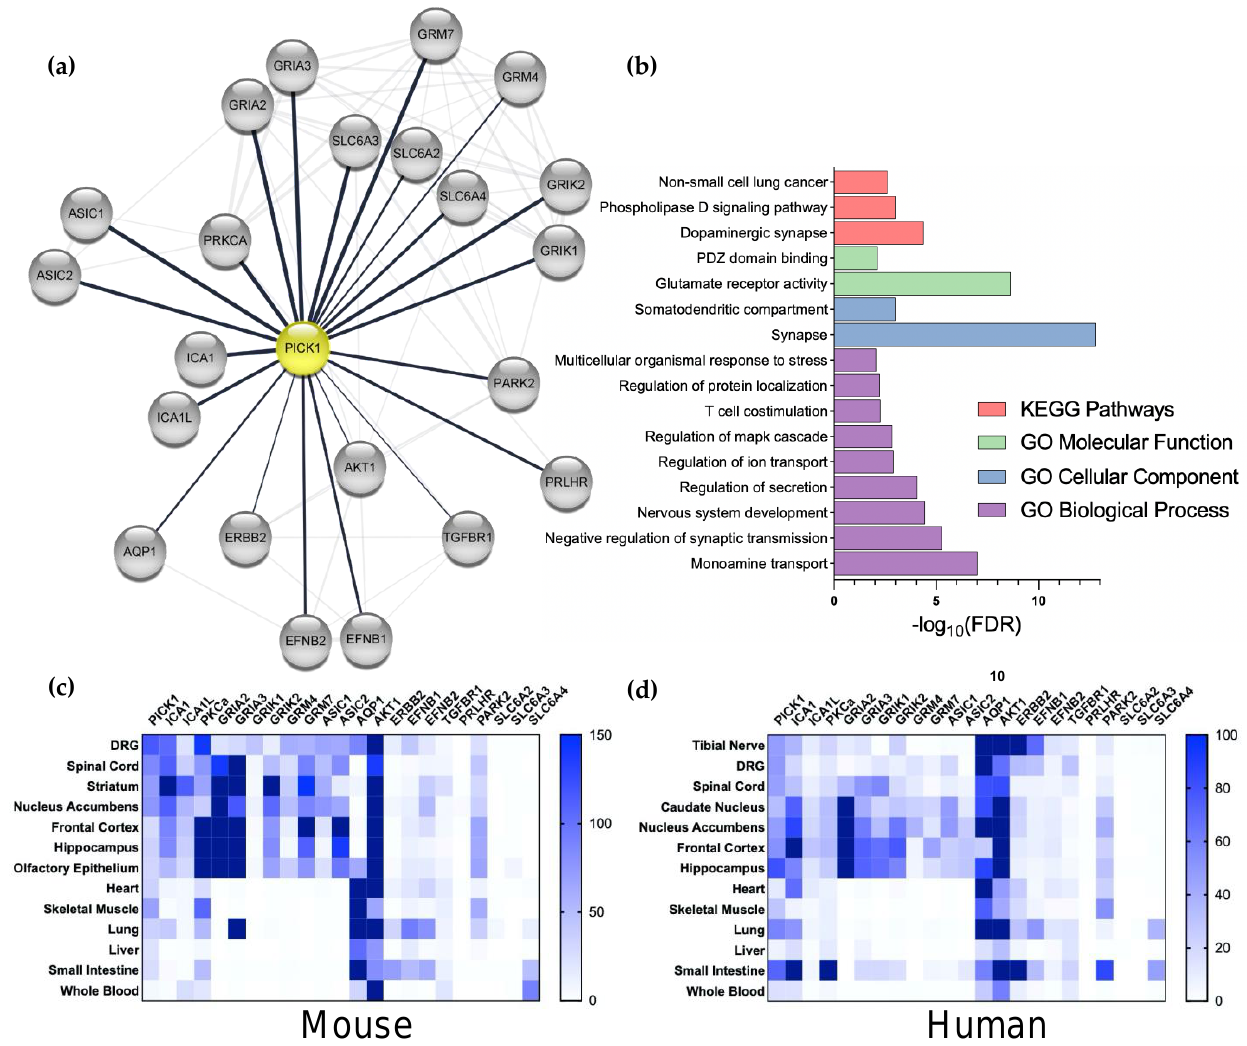
Figure 2. Analysis of the interaction and expression patterns of PICK1. ( a ) The stringApp (Doncheva et al. 2019) was used in Cytoscape to merge the network of pain-related proteins (1122 proteins from 5 databases, see Material and Methods) with PICK1 interaction partners (105 proteins, determined by the experiment score) to yield a functional protein-association network for Pain and PICK1 with 39 proteins. This network was manually validated by a literature search to yield a PICK1 network of 22 interactors. ( b ) The network was analyzed with respect to the biological pathways, processes, functions, and cellular compartments; FDR; Benjamini – Hochberg-adjusted p -values (see Materials and Methods). ( c , d ) heatmap of the mRNA expression of PICK1 and its pain-related interaction partners in selected mice ( c ) and humans ( d ) Tissue. Dorsal root ganglion (DRG), spinal cord, and tibia nerve (human) are the primary pain-related tissues.